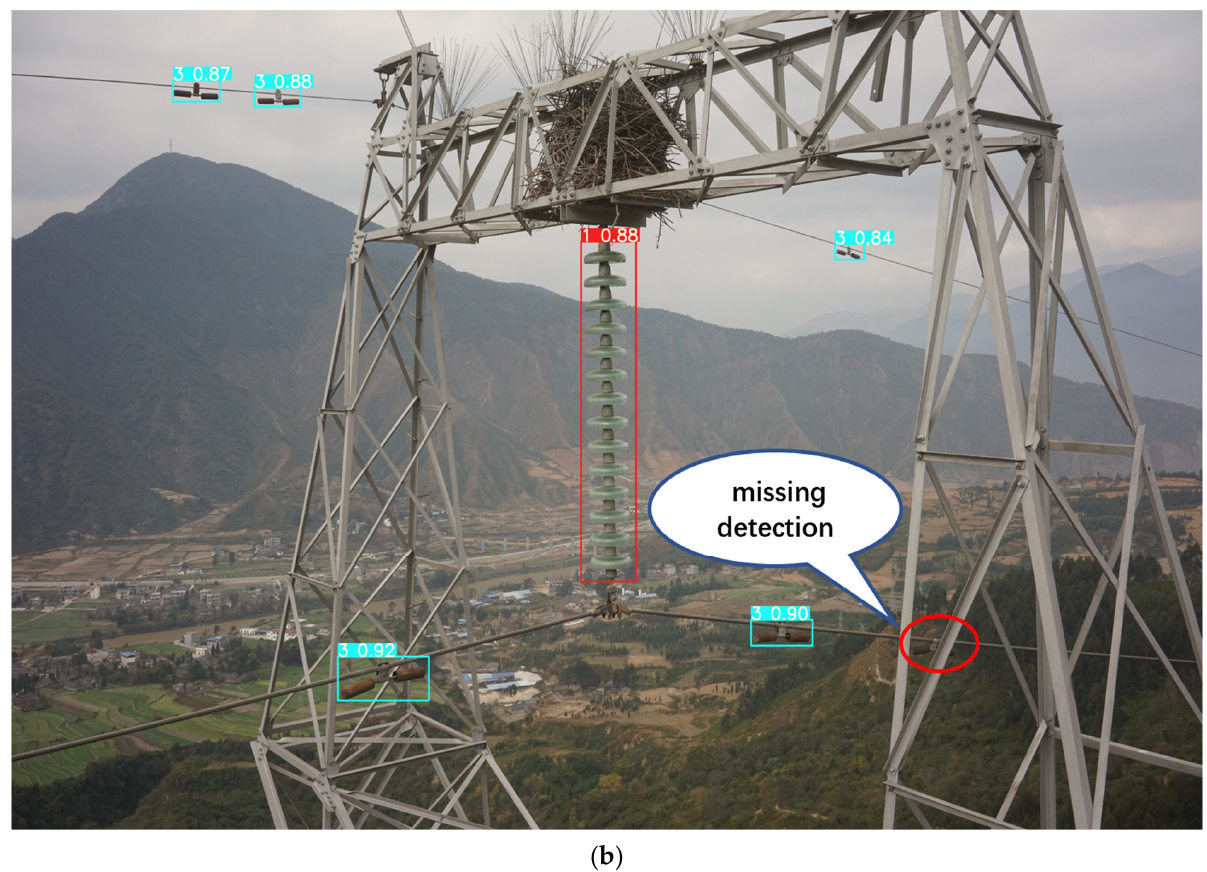
Figure 17. Example of partially missed detection: (a) Color confusion miss detection; (b) Missing detection from masking.